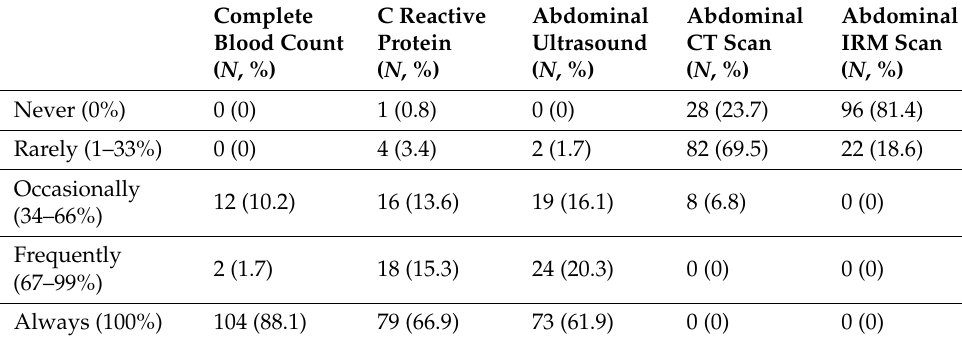
Table 2. Laboratory & imaging tests